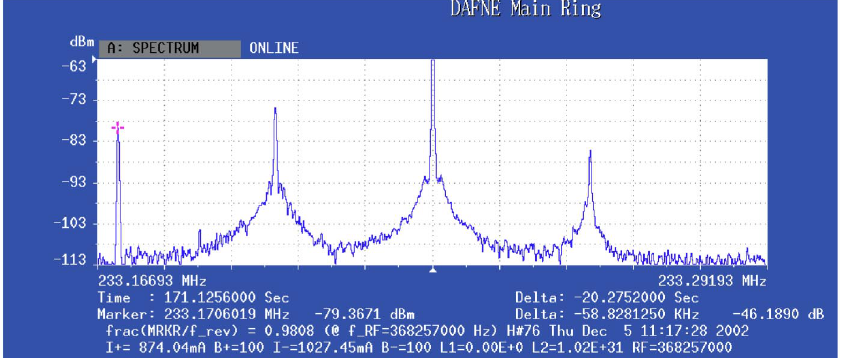
FIG. 16. (Color) Positron beam frequency power spectrum showing a q -pole excitation at 874 mA, in collision (the q -pole left sideband has the cross marker, the right sideband is missing, the revolution harmonic in this case is in the middle).